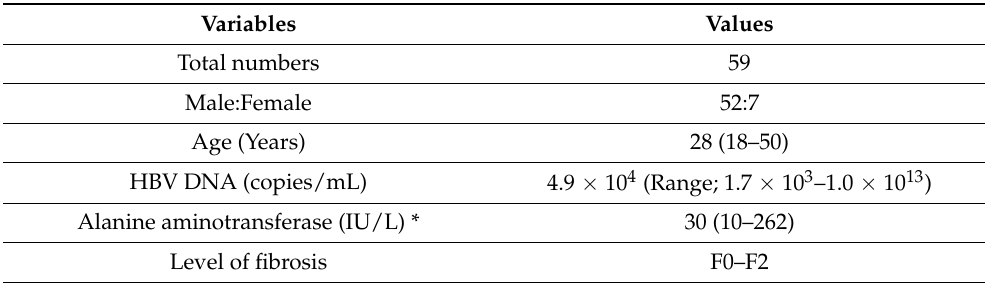
Table 1. Characteristics of the patients enrolled in this study on the day prior to administration of 1st dose of